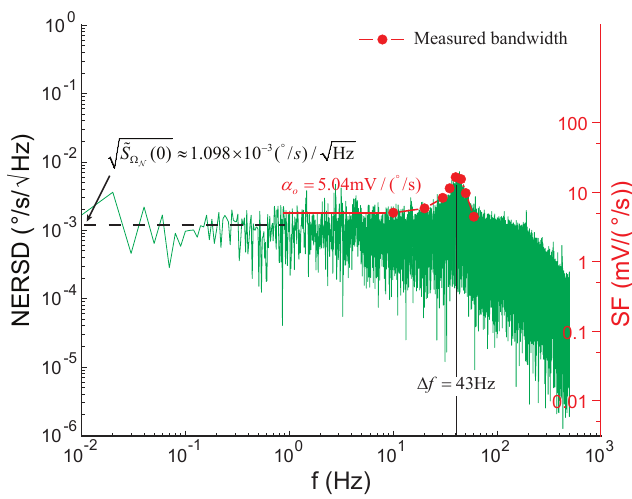
Figure 17. The NER spectral density of the open-loop gyroscope tuned by a DC voltage of 5 V and the corresponding gyroscope frequency response.